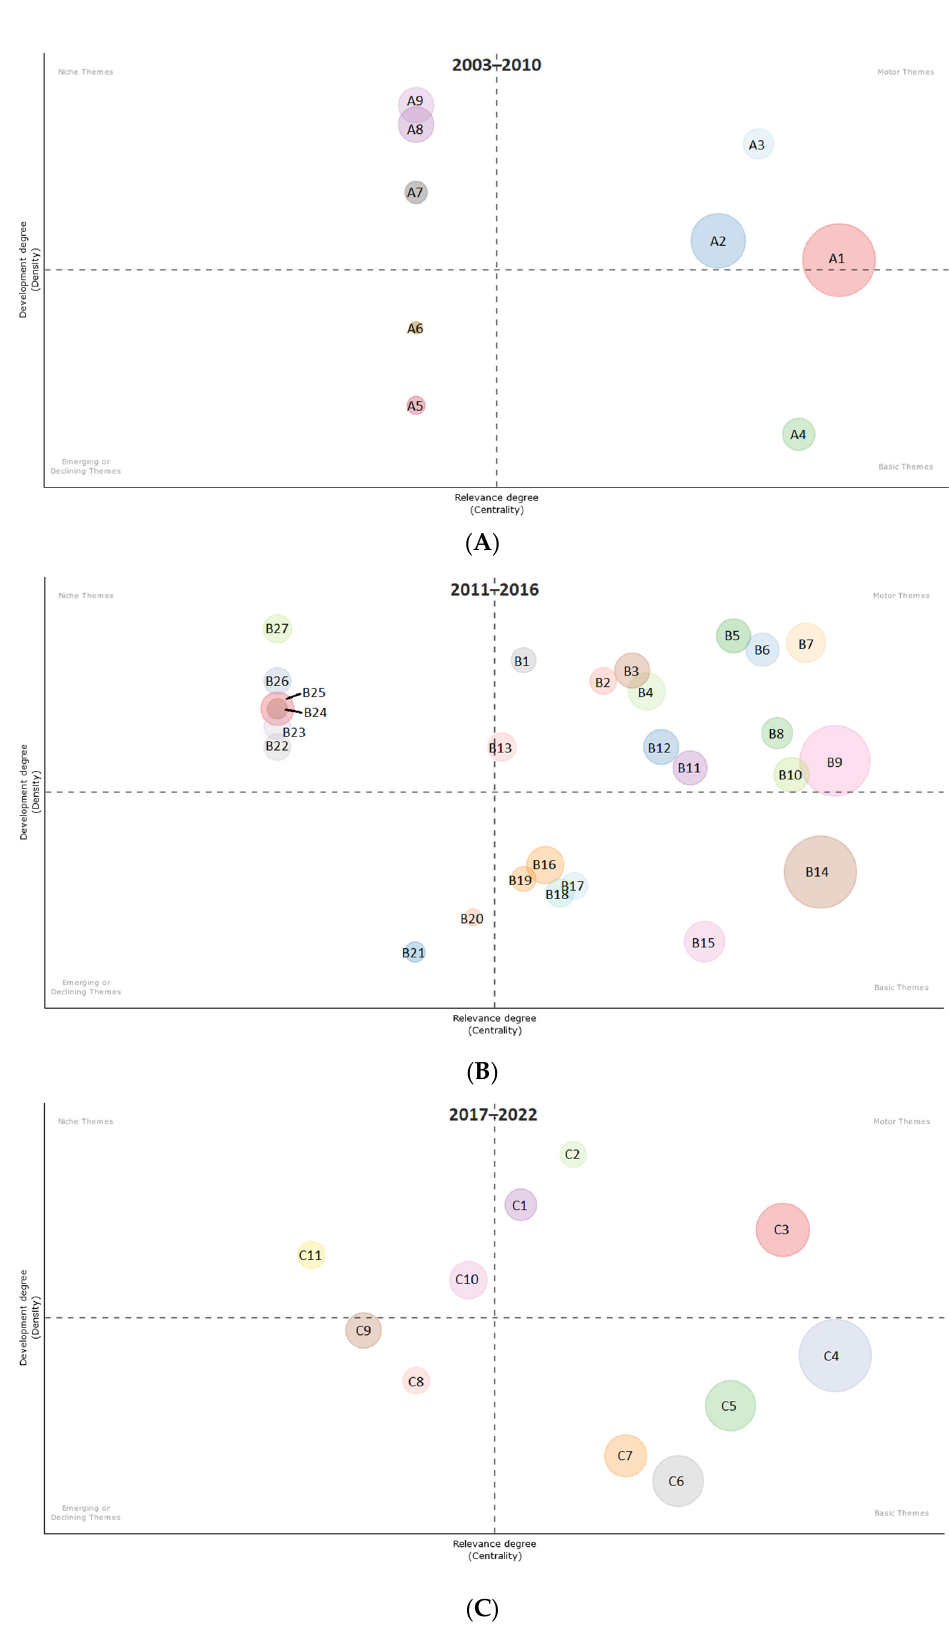
Figure 6. Thematic maps of the BM&OI literature. ( A ). Thematic map for the 2003–2010 period. A1: innovation, open innovation, business models; A2: business model, open-source software, value creation; A3: web 2.0, knowledge management system; A4: business model innovation,